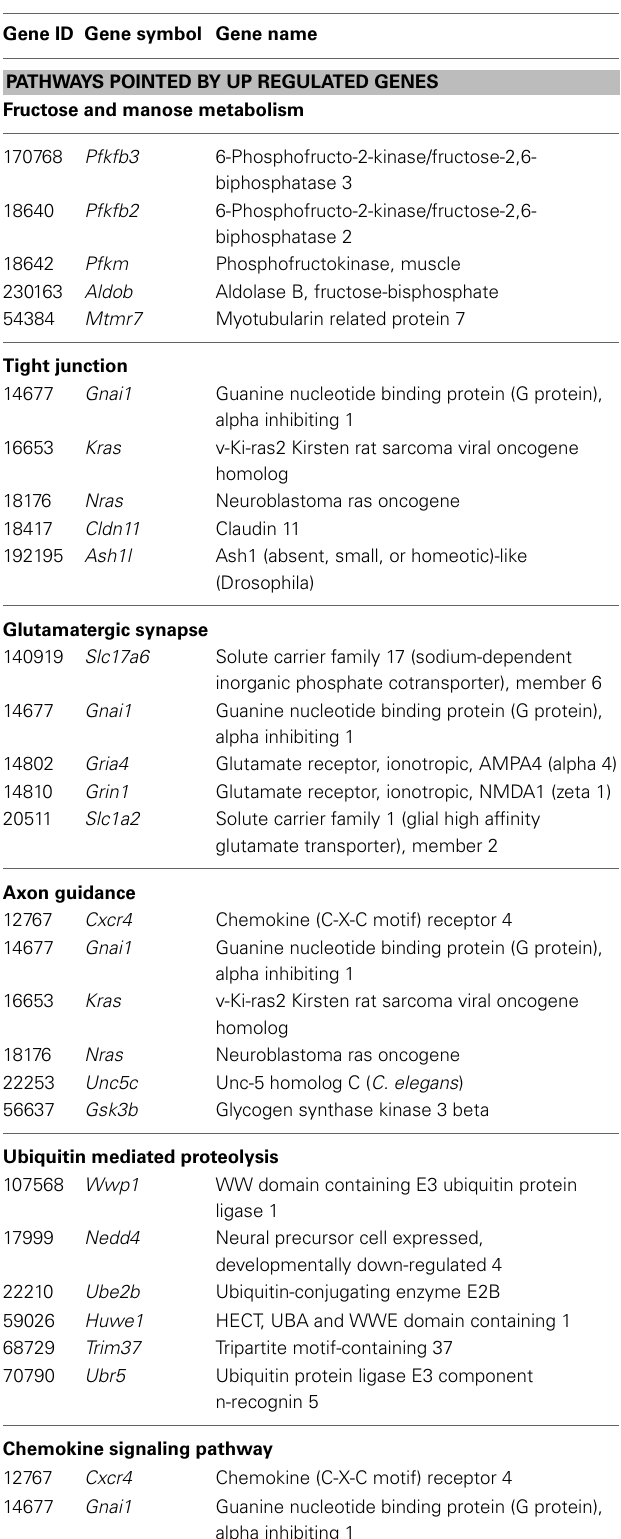
up or down regulated genes at 40 days old